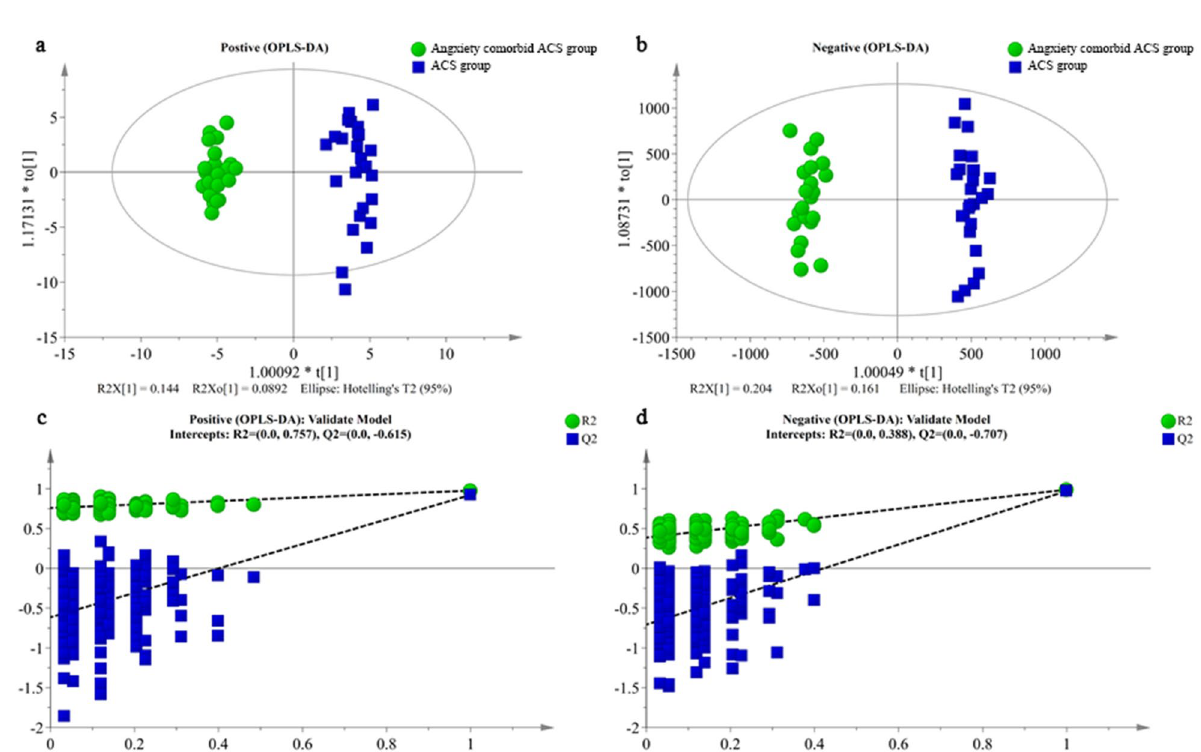
Figure 5. The OPLS-DA score plots and sorting validation figures derived from LC–MS analysis of plasma from anxiety comorbidity ACS and ACS group in positive ion mode ( a , c ), and in negative ion mode ( b , d